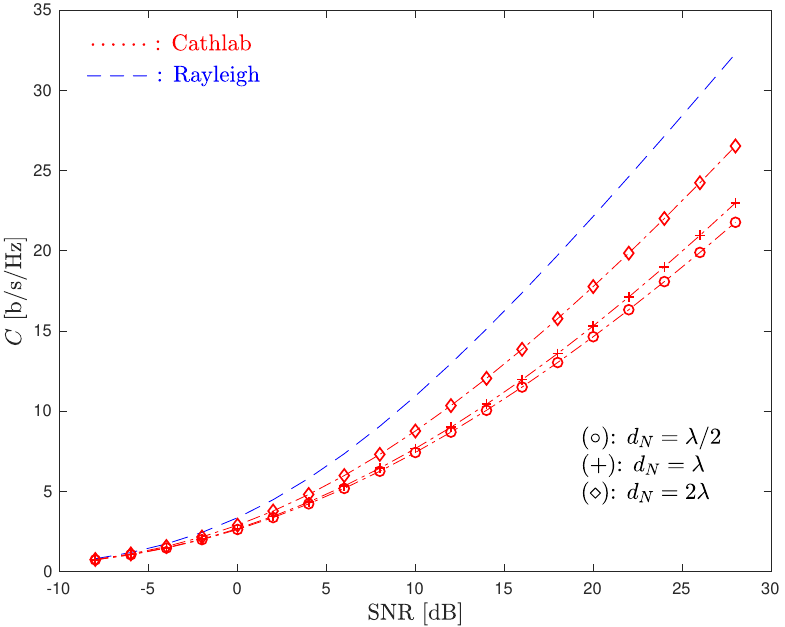
Figure 11. Ergodic system capacity with Rayleigh and CathLab channels with different values of d N